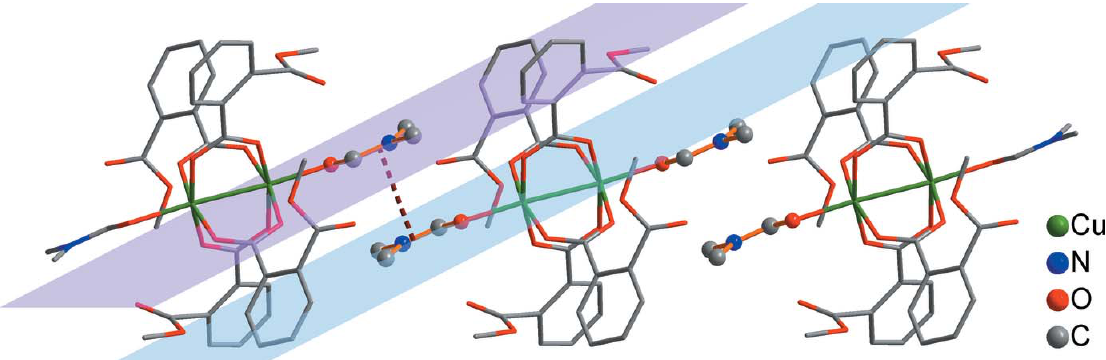
Figure 2 The one-dimensional motif from the binuclear copper fragments of (I) along the c- axis direction formed by (cid:2) – (cid:2) stacking interactions (dashed lines) between the coordinated DMF